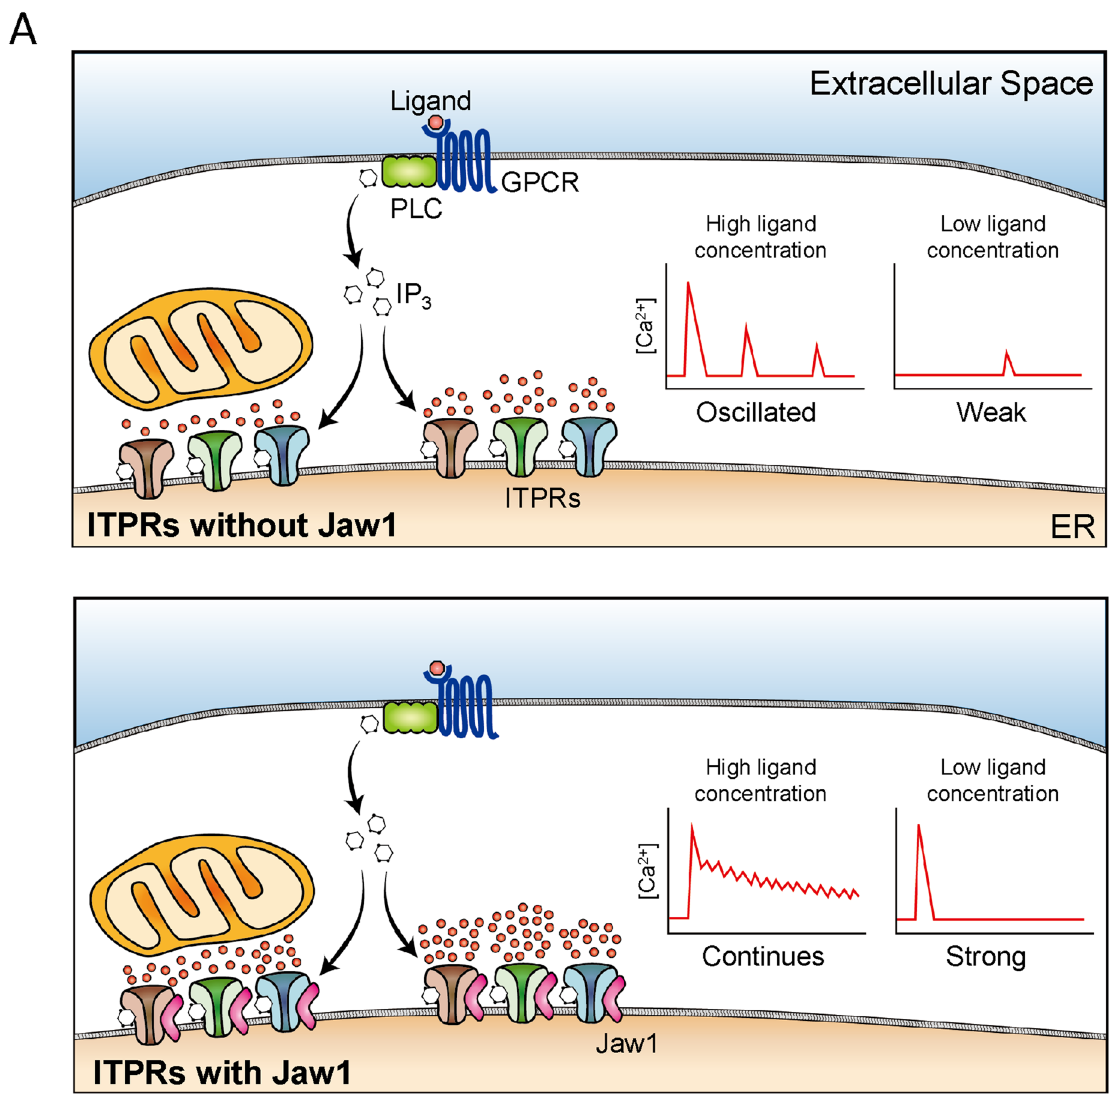
stimulation. Jaw1 changes the Ca 2+ influx pattern from oscillated response to continuous response in high GPCR stimulation, and from weak response to strong response in low GPCR